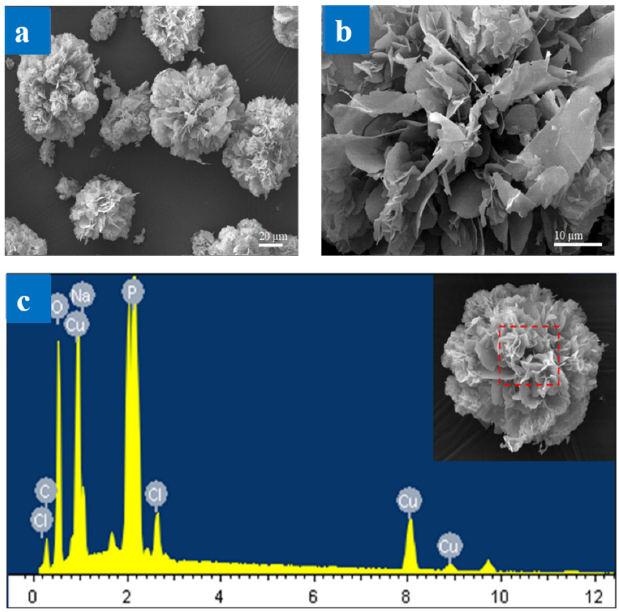
Figure 4. ( a , b ) SEM images of SF@Cu ‐ NFs product with low and high magnification; ( c ) EDS pattern of SF@Cu ‐ NFs product.